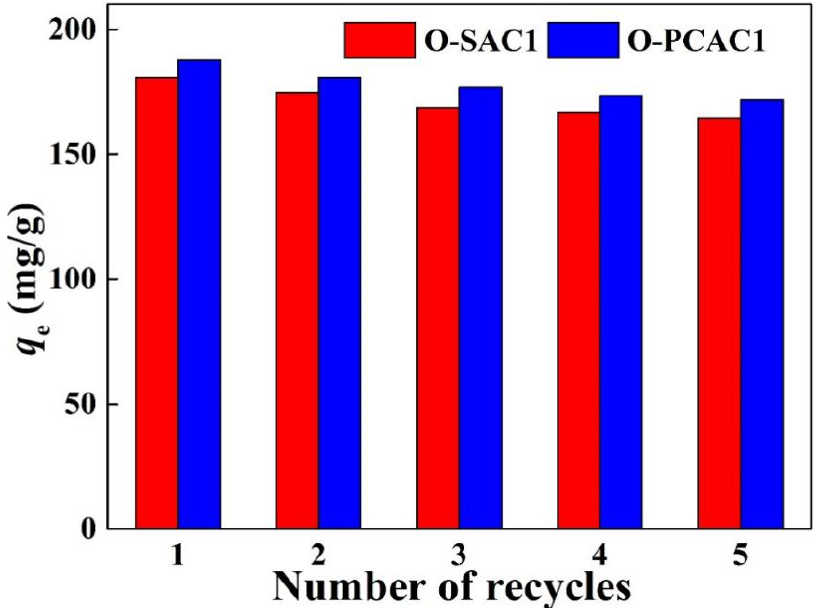
Figure 6. Reusability of IMACs for the adsorption of NAP (NAP concentration 30 mg/L, contact time 80 min) after elution with 95% ethanol solution in ultrasound field.